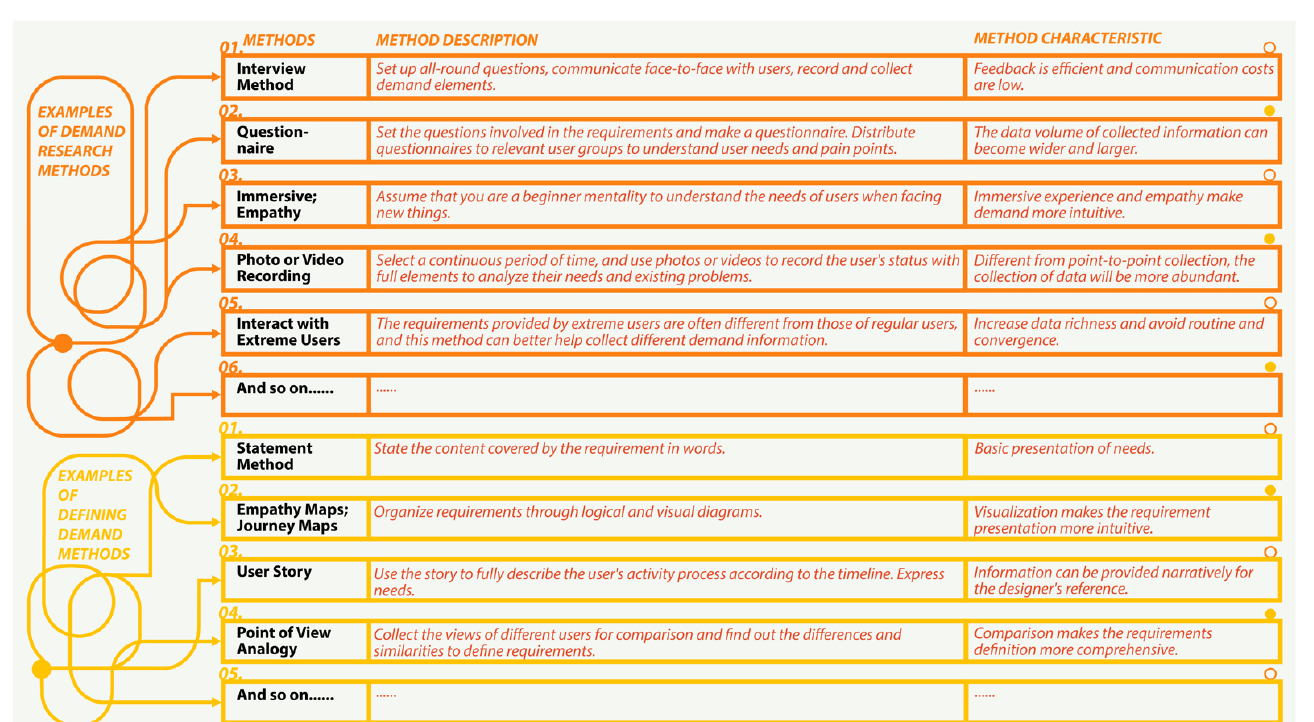
Figure 14. Examples of methods for demands research and definition.